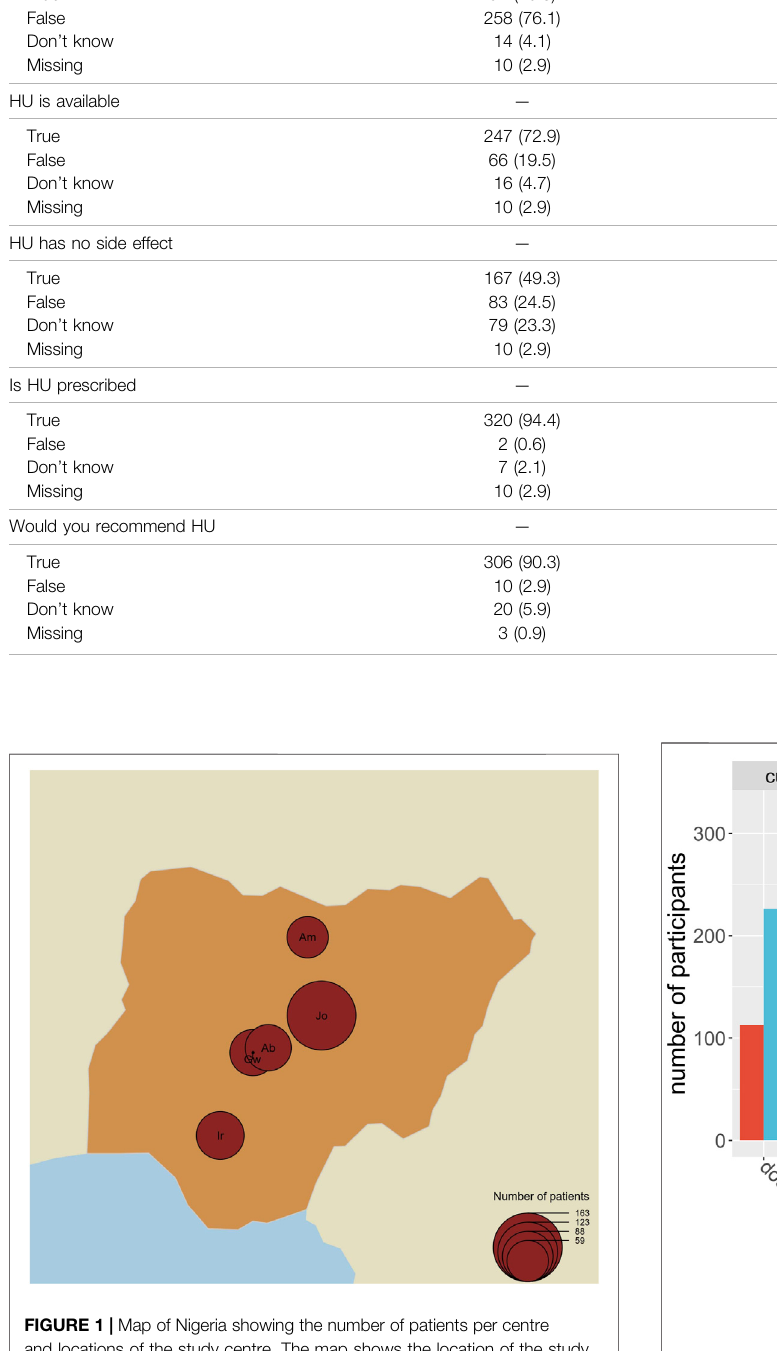
FIGURE 2 | Participants were asked a set of 4 questions, shown on the x-axis, around their perceptions of hydroxyurea (hu). The number of participants (y-axis) answering yes (blue) orno (red) are shown by thebars, for those who are currently using hu (left plot) and for those who did use hu but had stopped at the time of the questionnaire (right